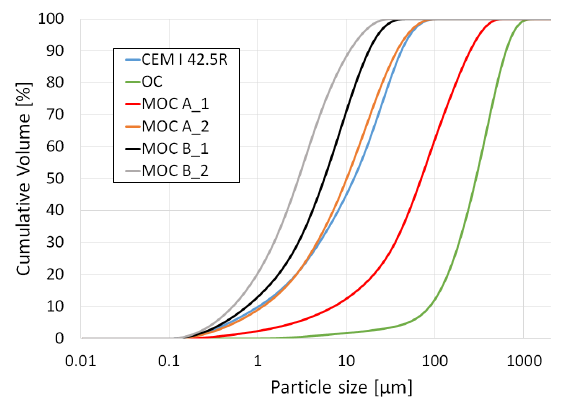
Figure 2. Partical size distribution curve of used